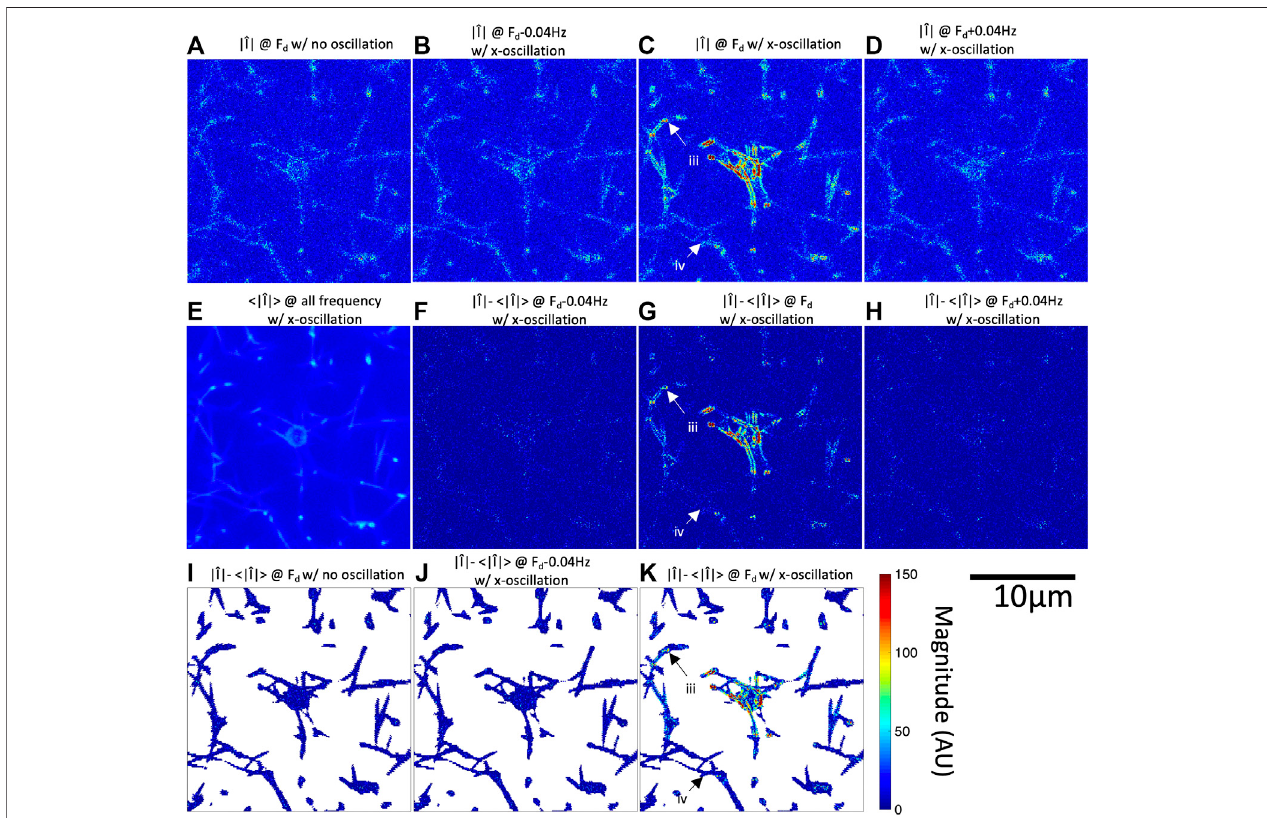
FIGURE 2| Fourier magnitudeimage at F d identi fi es subsets of fi bers which oscillate with theoptically trapped bead. Identi fi cation ofthese fi bers can be improved by mean-magnitude background subtraction and masking of the liquid regions. (A) Fourier magnitude at F d with no applied bead oscillations. Fourier magnitude at (B) F d − 0 . 04 Hz, (C) F d , and (D) F d + 0 . 04 Hz while the bead is oscillated in the x -direction. (E) Mean magnitude image over all frequencies excluding 0 Hz and F d . Mean- magnitudesubtractedimagesat (F) F d − 0 . 04 Hz, (G) F d ,and (H) F d + 0 . 04 Hzwhilethebeadisoscillatedinthe x -direction. (I) Mean-magnitudesubtractedimage at F d while bead is not oscillated displaying only pixels covering the fi ber network. (J) Mean-magnitude subtracted image at F d − 0 . 04 Hz displaying only pixels covering the fi bernetwork. (K) Mean-magnitudesubtractedimageat F d displayingonlypixelscoveringthe fi bernetwork.Arrowsinpanel (C,G,K) indicatelocationsofpixels iii and iv in Figure 1